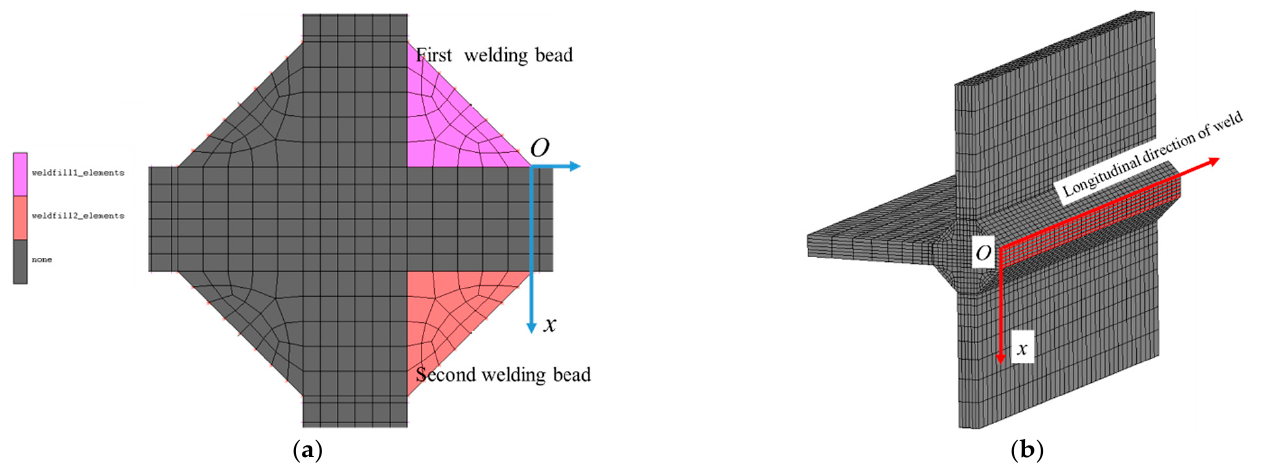
Figure 8. Weld bead and extraction path of transverse residual stress. ( a ) Schematic of bead fill for single pass welding; ( b ) Extraction path of transverse residual stress in crack propagation plane.